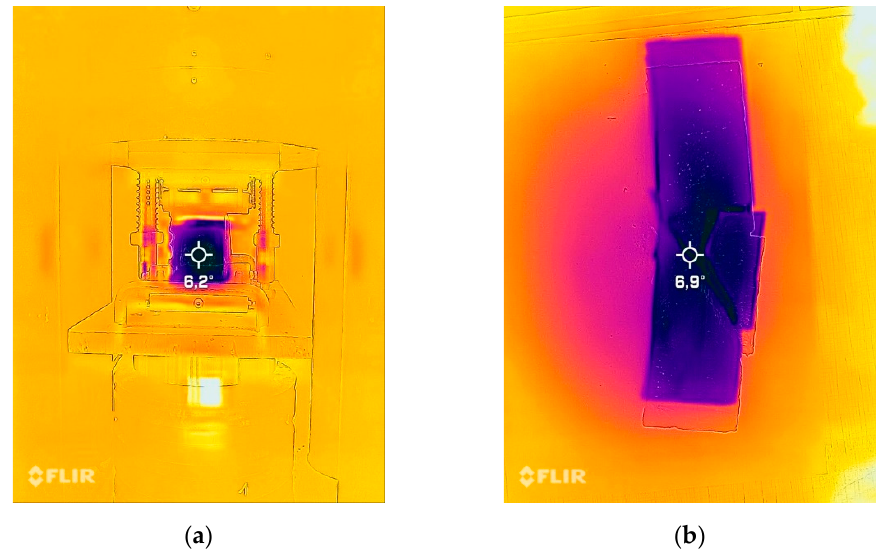
Figure 9. Measurement of change in thermal radiation made using an FLIR thermal imaging camera. ( a ) Sample during the bending test. ( b ) Sample after the bending test.